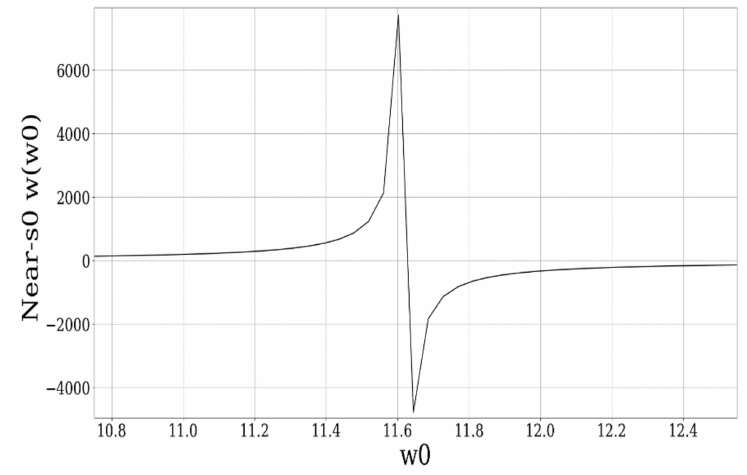
Figure 5. Plot of 𝑤(cid:4666)𝑠(cid:4667) peak in the vicinity of 𝑠 (cid:2868) . Figure 5. Plot of w ( s ) peak in the vicinity of s 0 . Large 𝑀 values (of the order of hundreds) produce these left-right-hand regimes,